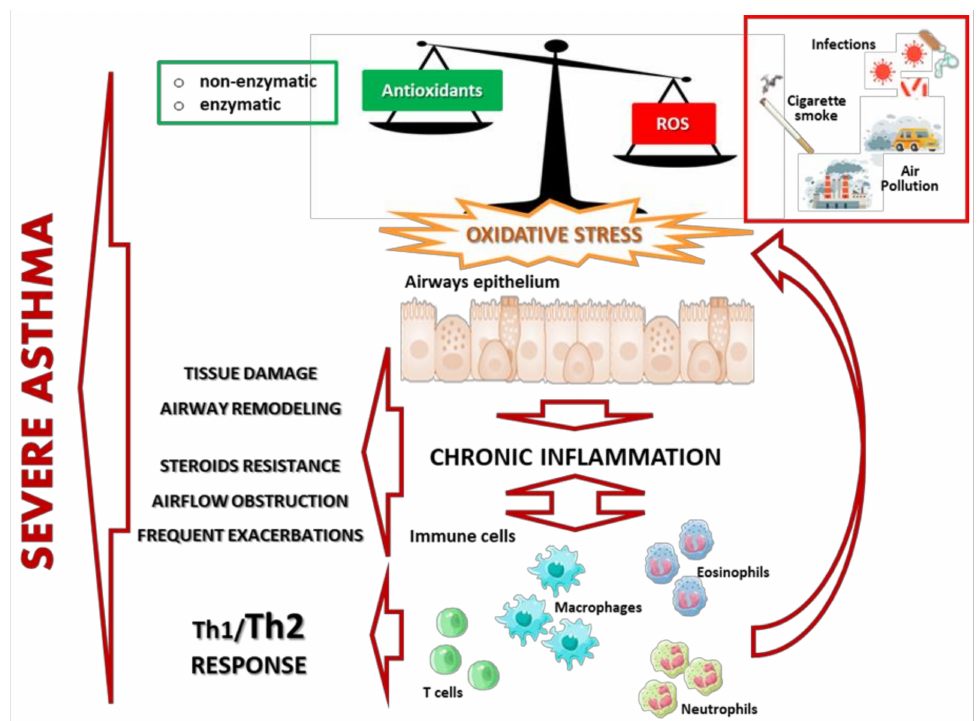
Figure 1. Summary of proposed mechanisms that contribute to oxidant/antioxidant imbalance in asthma